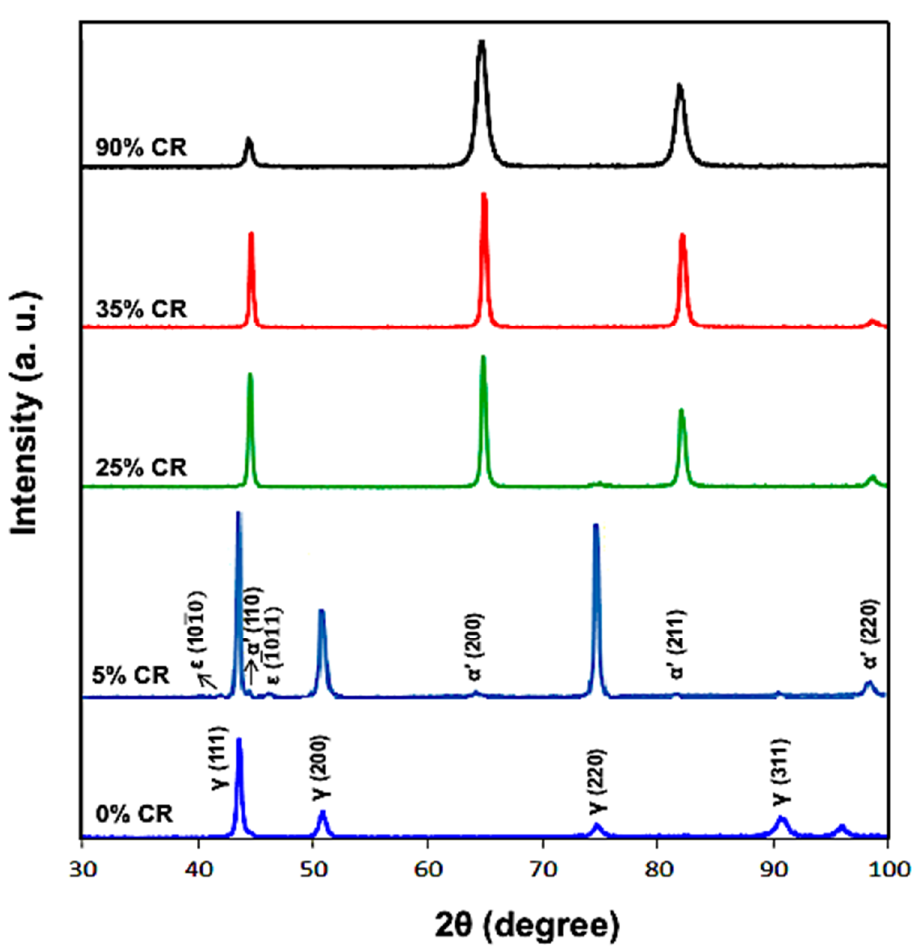
Figure 2. X-ray di ff raction patterns of the cold rolled Ti-bearing 201L steel after di ff erent Figure 2. X-ray diffraction patterns of the cold rolled Ti-bearing 201L steel after different thickness thickness reductions.